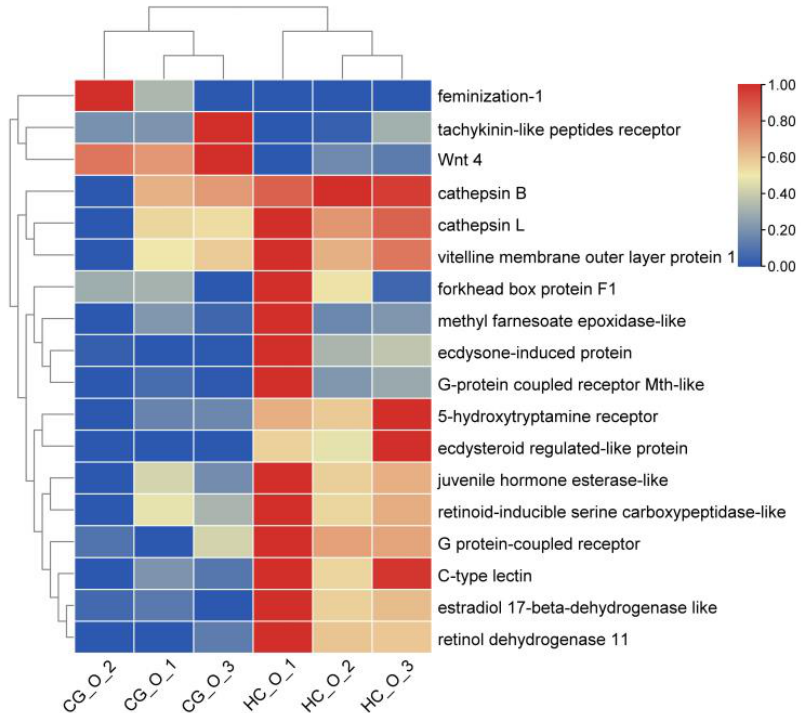
Figure 5. The heatmap of DEGs related to ovarian development in the HC_O vs. CG_O group. The columns and rows indicate individuals and genes, respectively. The color scale represents FPKM after standard normalization, the same as below.